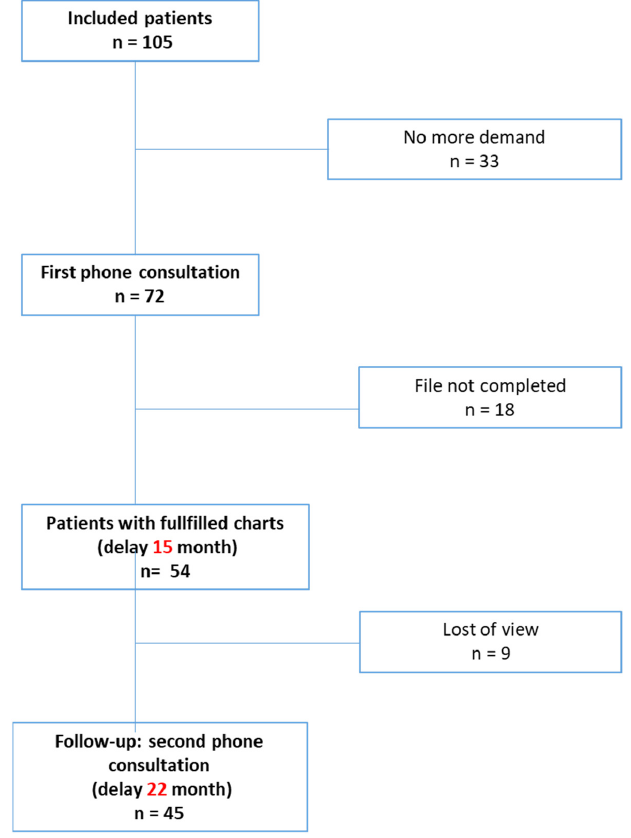
Figure 2. Flow-chart of the study.